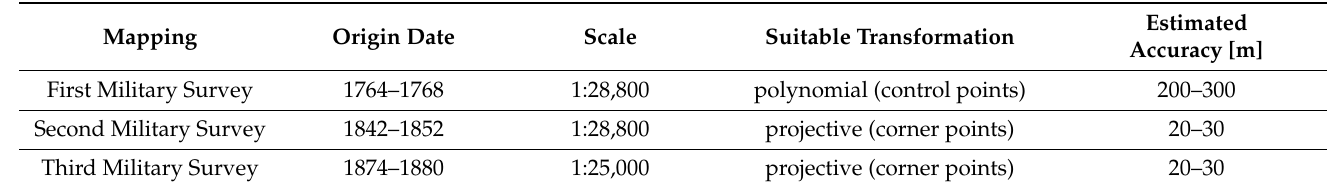
Table 2. Topographic surveys of the Habsburg Monarchy in the research area, Source: author’s elab- oration.